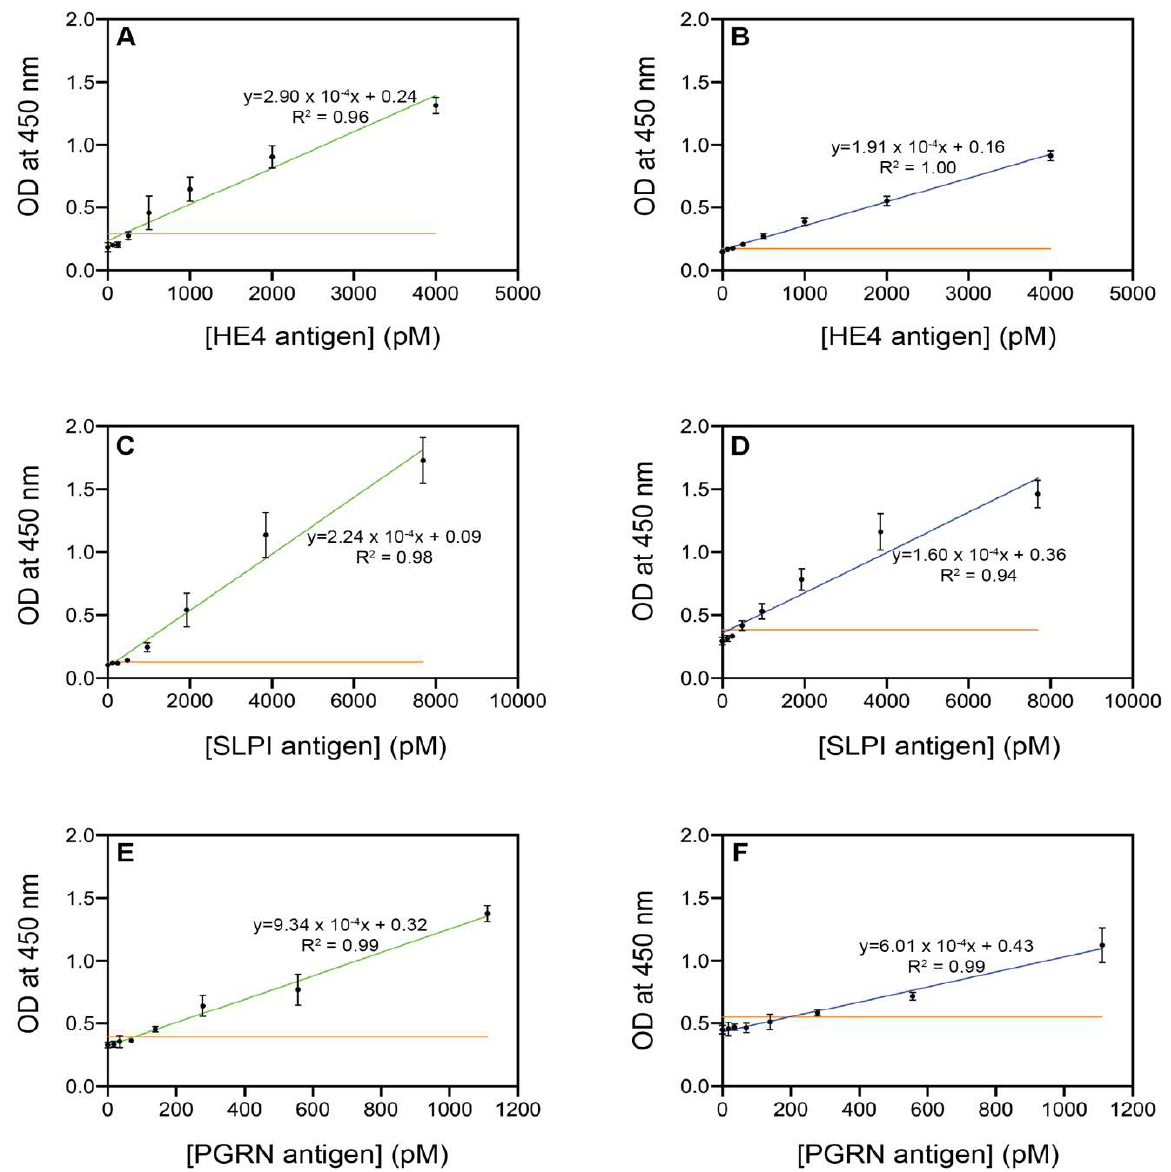
Figure 4. Sandwich ELISA plots showing the detection results of the recombinant human antigens HE4, SLPI, and PGRN by their respective best-performing nanobodies: HE4-6 in PBS ( A ) and serum ( B ); SLPI-1 in PBS ( C ) and serum ( D ); and PGRN-5 in PBS ( E ) and serum ( F ). The yellow line indicates the LOD.